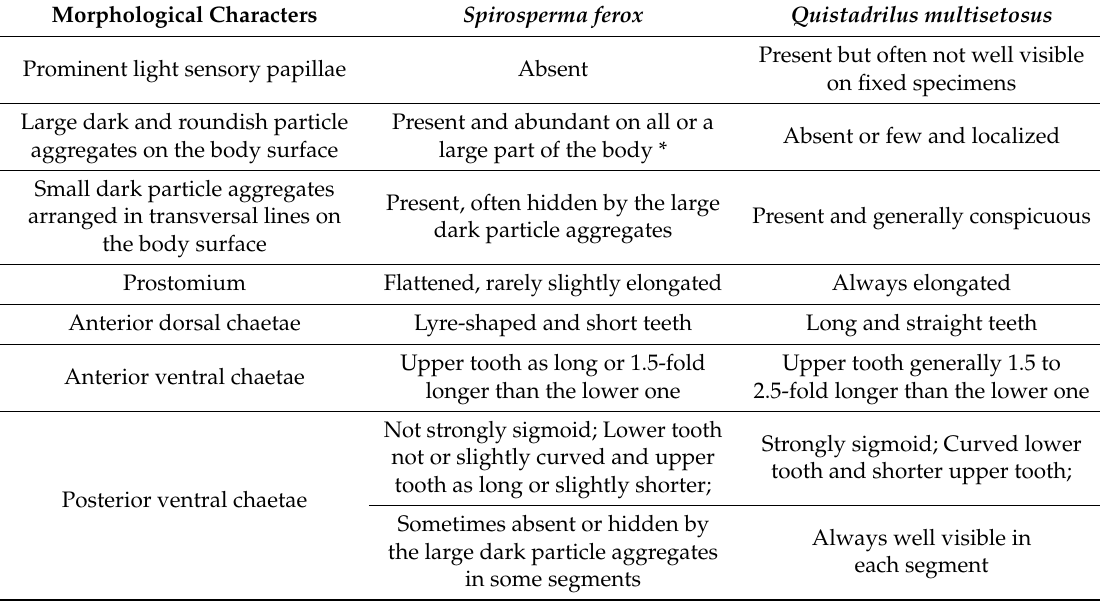
Table 2. Summary of the morphological di ff erences between Quistadrilus multisetosus and Spirosperma ferox , mostly based on the authors’ own